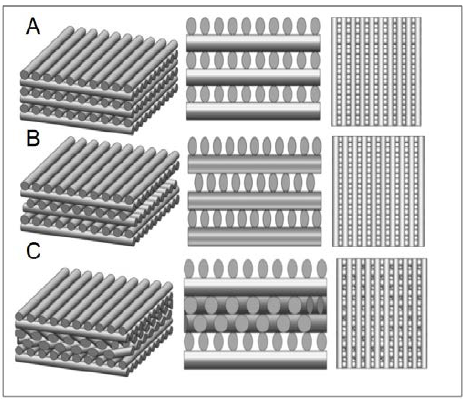
Figure 2. The structure of ( A ) lay-down patterns 0°/90°(90ECR/90ECR); ( B ) staggered Figure 2. Thestructureof( A )lay-downpatterns0 ◦ /90 ◦ (90ECR/90ECR); ( B ) staggered 0 ◦ /90 ◦ (SECR/SECR); 0°/90°(SECR/SECR); and ( C ) 0°/90°/+45°/ − 45° (45ECR/45ECR) scaffold designs. and ( C ) 0 ◦ /90 ◦ /+45 ◦ / − 45 ◦ (45ECR/45ECR) scaffold